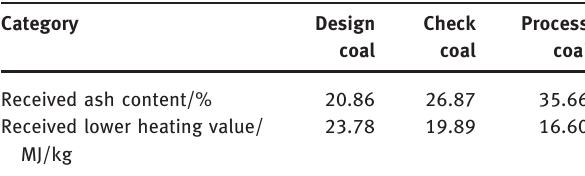
Table 4: Analysis of design coal, check coal and using coal quality.